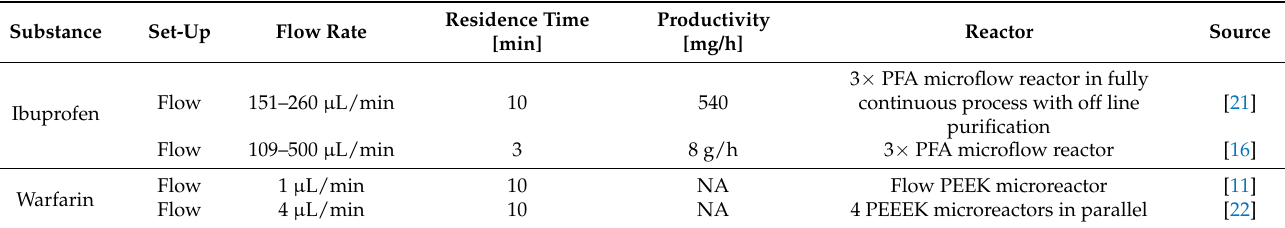
Table 1. Summary table of flow preparations of